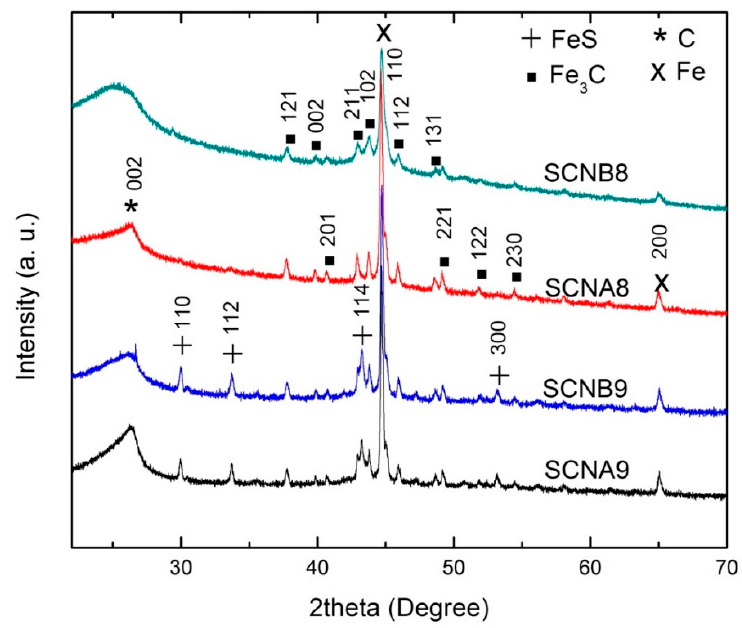
Figure 1. X-ray diffraction patterns of S added carbon nanohorns (S-CNHs).